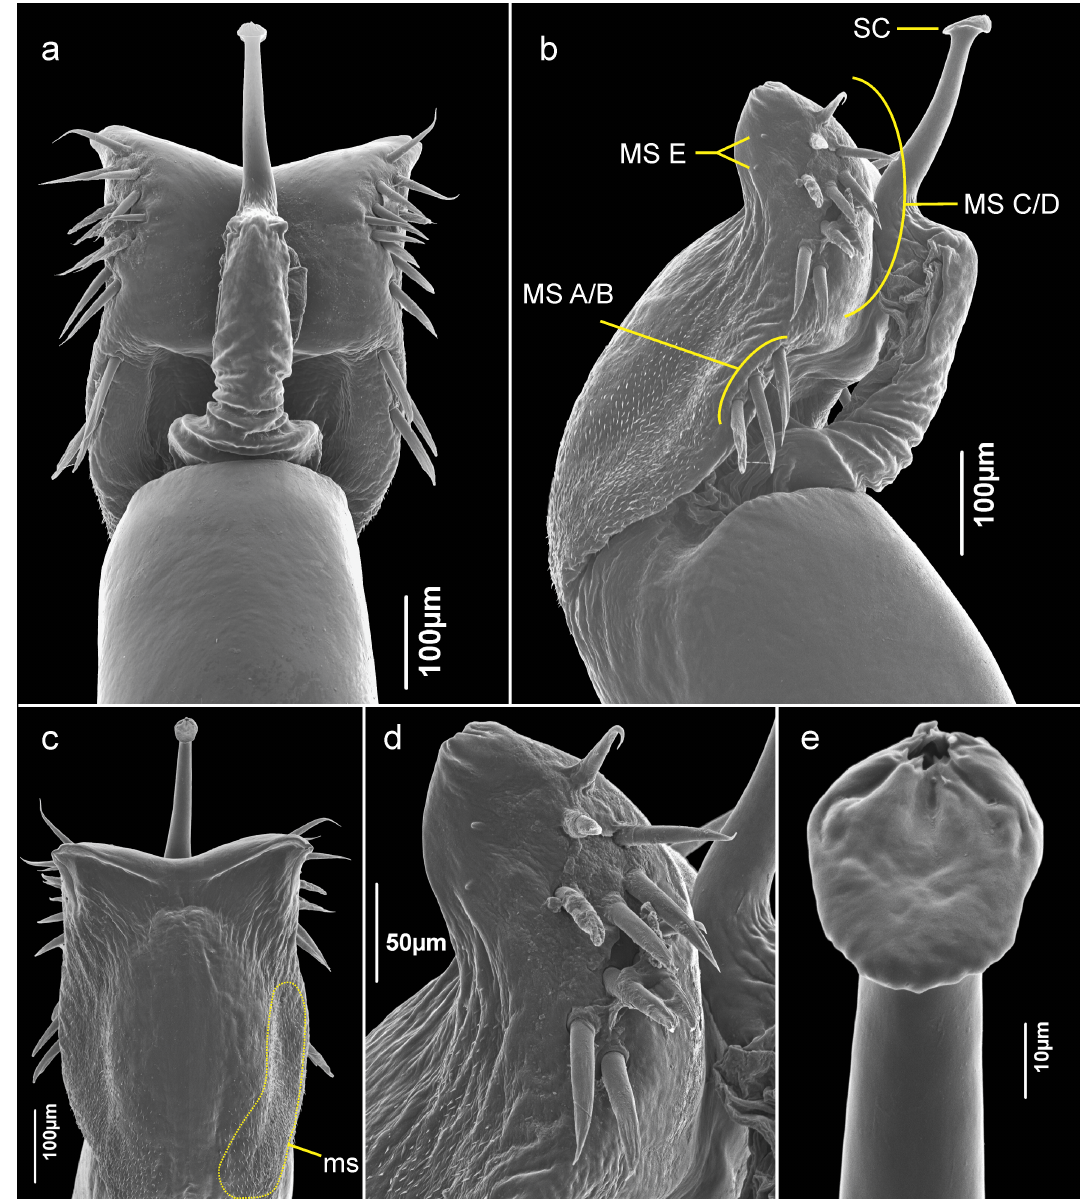
Fig. 3. Phalangodus anacosmetus Gervais, 1842 (ICN-AO-1000), penis distal portion. a . Dorsal view. b . Lateral view. c . Ventral view. d . Detail of MS C, MS E and microsetae, lateral view. e . Stylar caps, ventrodistal view. Abbreviations: see Material and